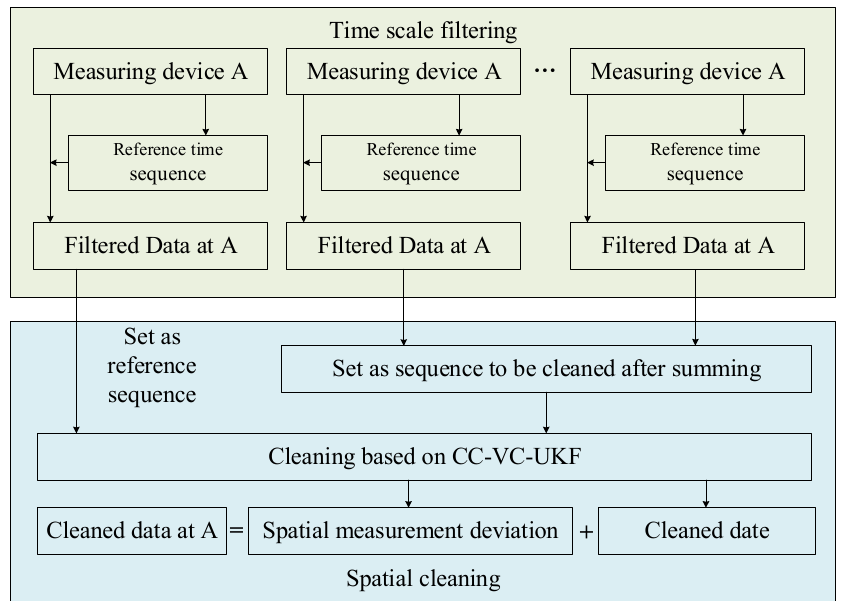
Figure 6. Flow chart of multistage data filtering technology based on space–time.